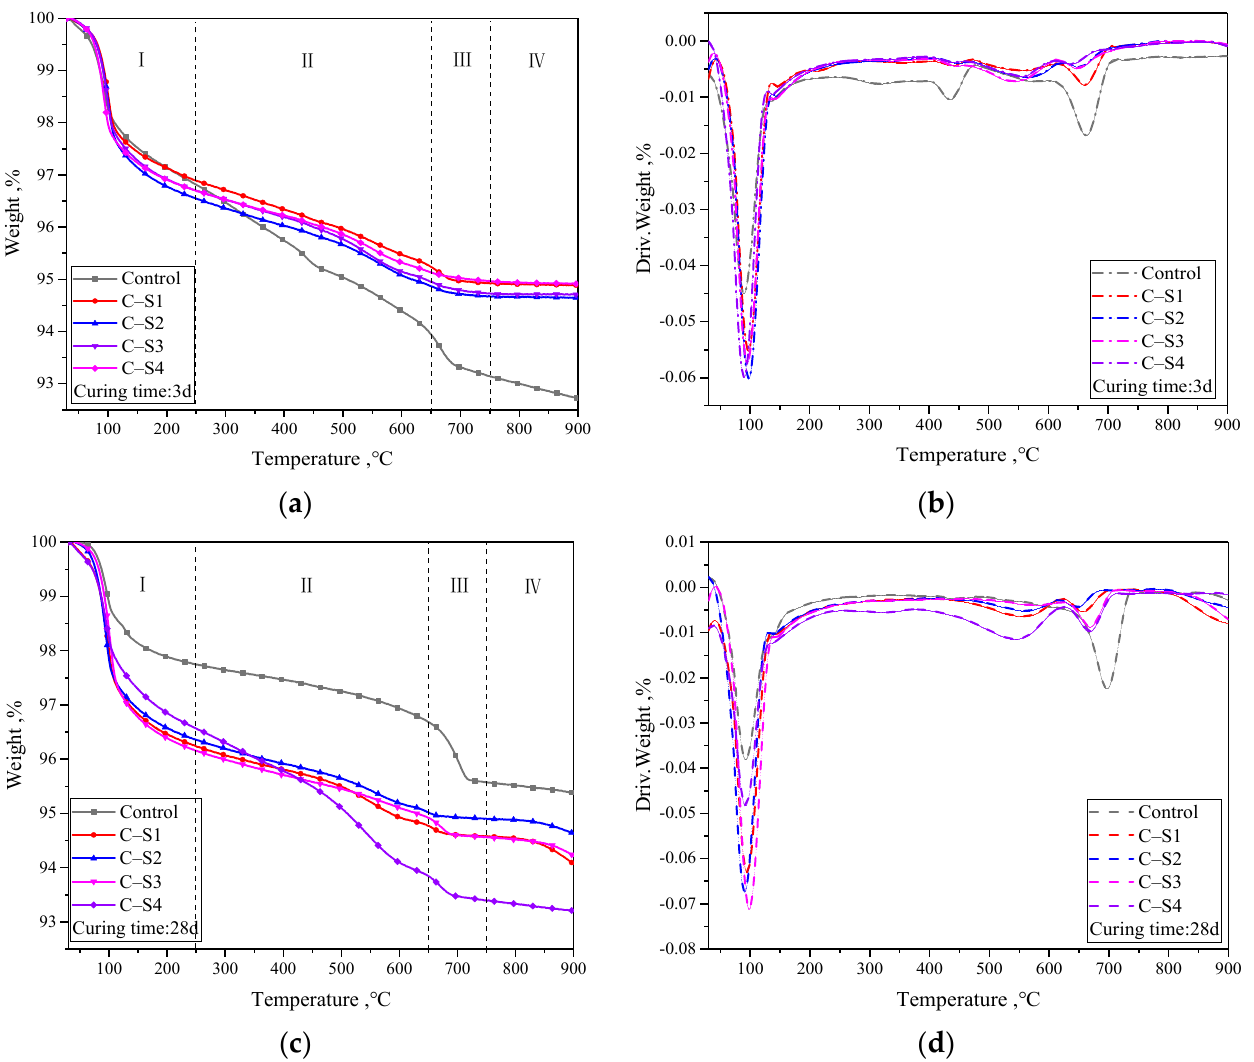
Figure 10. TG-DTG results of PCCPB samples. ( a ) 3d sample mass and temperature relationship( b ) 3d sample mass loss rate of change and temperature ( c ) 28d sample mass and temperature relationship ( d ) 28d sample mass loss rate of change and temperature Table 4 reflects the weight loss rates of PCCPB with various Na 2 SO 4 dosages, and the magnitude of the weight loss rate indirectly reflects the number of hydration products in a given temperature interval [62]. In the I zone, the weight loss of free water, C-(A)-S-H, and AFt in PCCPB was the first to increase and then to decrease with the increase in Na 2 SO 4 dosage. The most significant weight loss in the PCCPB samples for curing time of 3 d was C-S2, which was 3.45% (zone I), of which the free water weight loss represented a relatively large ratio. The most significant weight loss in the PCCPB samples for a curing time of 28 d was C-S3, which was 3.84% (zone I), with C-(A)-S-H and AFt accounting for a relatively large proportion of the weight loss. This is consistent with the findings in Sections 3.1 and 3.2.4. In addition, mass loss in zone I was found to be higher for all samples at 28 d than at 3 d, indicating that PCCPB continued hydration with increasing age. This is consistent with the studies of Zhang et al. [63] and Feng et al. [64]. Table 4. Weight loss ratio of PCCPB with di ff erent Na 2 SO 4 dosages.